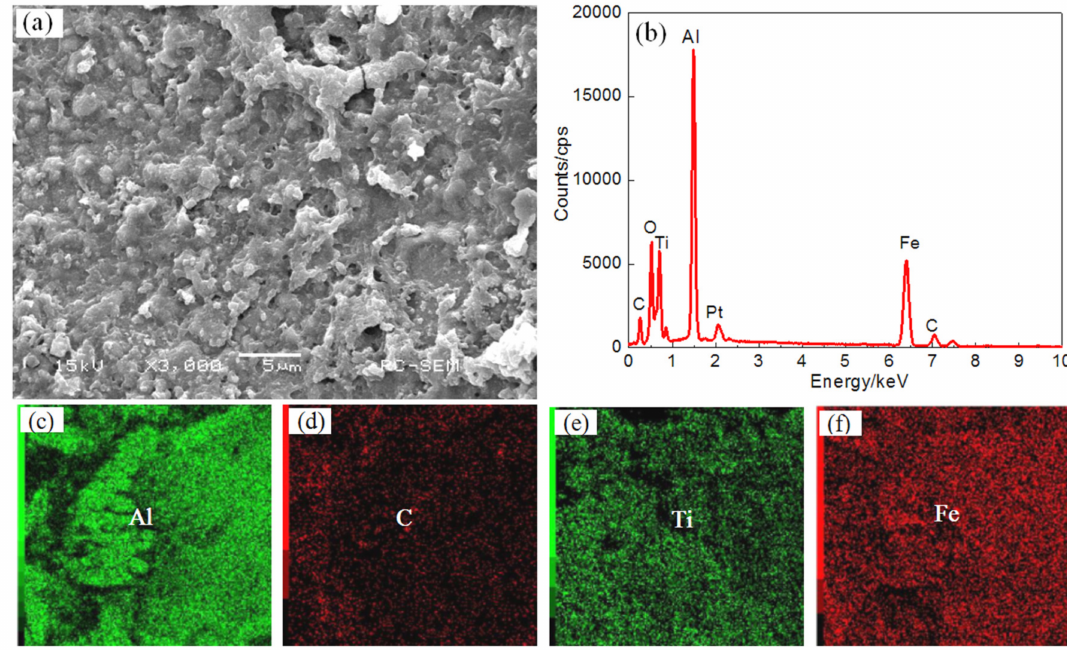
Figure 8. The surface SEM images ( a ) and EDS analysis result ( b ) and element content of Plane scan (( c ) Al content ( d ) C content ( e ) Ti content ( f ) Fe content) of Coating